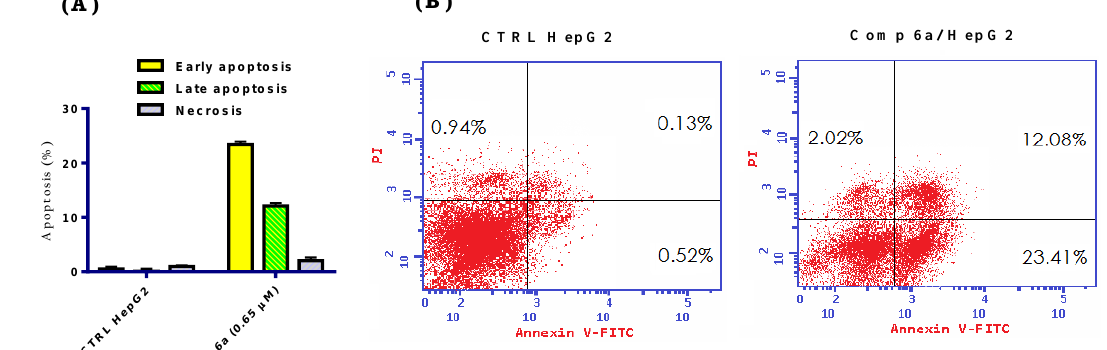
Figure 5. ( A ) Graphical representation shows the apoptosis effect by Annexin V-FITC versus PI uptake method in HepG2 cells after 48 h of compound 6a exposure at its IC 50 concentration ( µ M) compared with the untreated control. ( B ) Cryptograms show the apoptosis effect by the Annexin V-FITC versus PI uptake method in HepG2 cells after 48 h of compound 6a exposure at its IC 50 concentration ( µ M) compared with the untreated control.